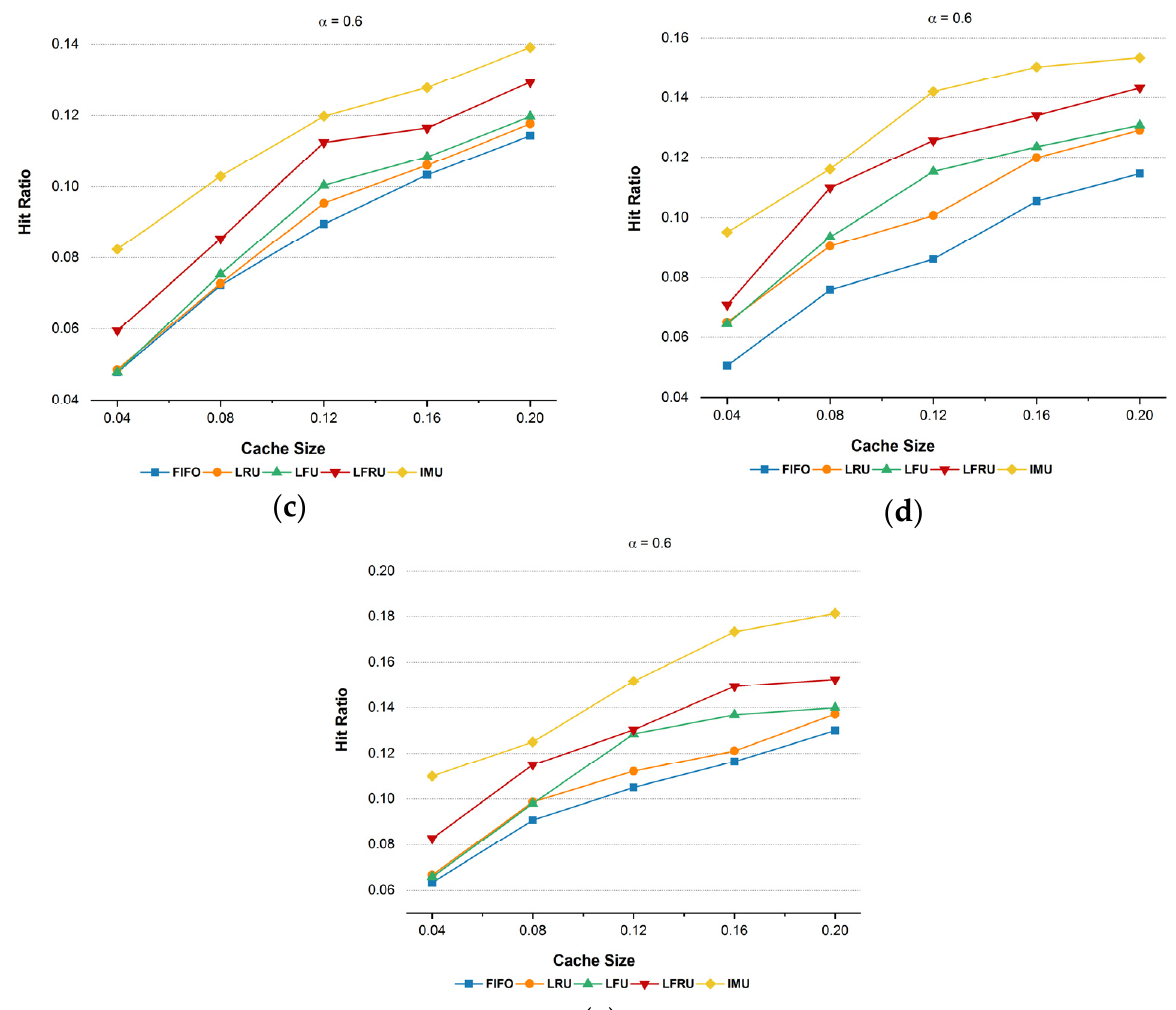
Figure 2. Caching hit ratio with different cache sizes and α by using different placement policies. ( a ) Cache hit ratio with LCE. ( b ) Cache hit ratio with CL4M. ( c ) Cache hit ratio with ProbCache. ( d ) Cache hit ratio with LCD. ( e ) Cache hit ratio with opt-Cache.